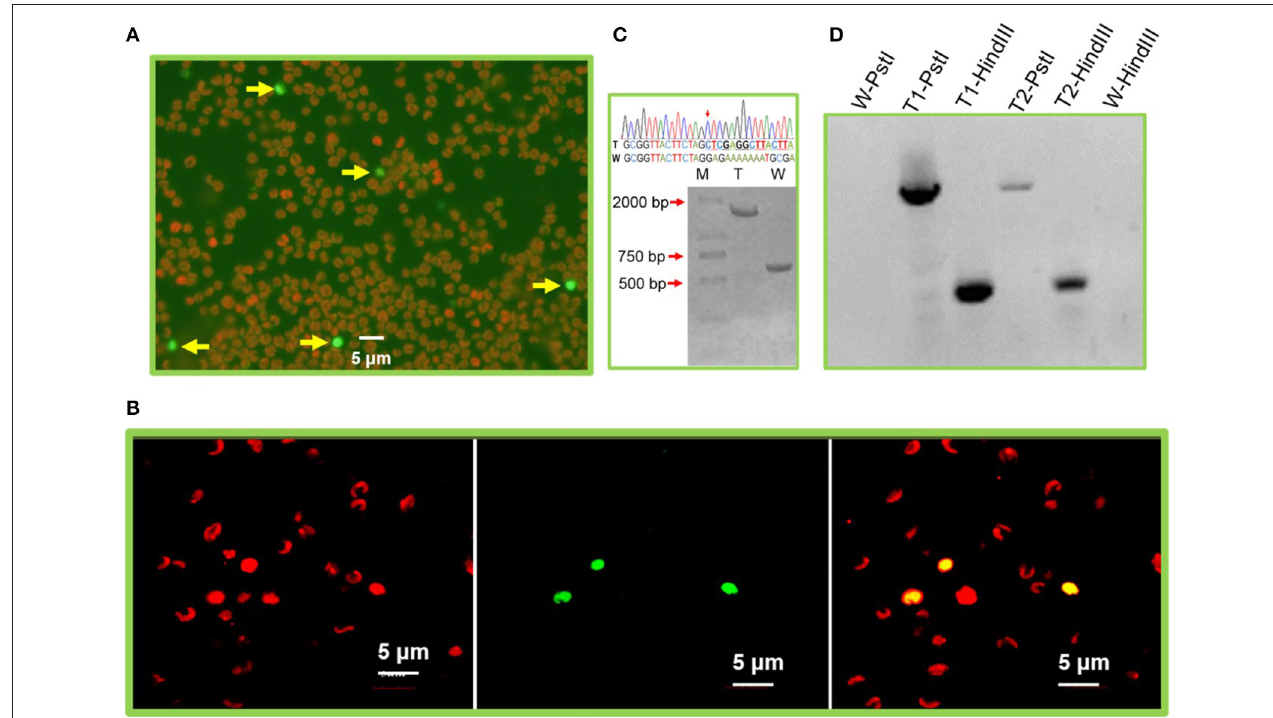
FIGURE 2 | Exogenous gene expression in the N. oceanica chloroplast. (A) Microscopy images of GFP signals from representative microalgal cells transformed by pMEMc1. The fluorescent micrographs show the GFP expressing cells with green color (excitation: 488nm, emission: 500–545nm) and wild type cells with auto red fluorescence of chlorophyll (excitation: 559nm, emission: 570–650nm). (B) Laser confocal microscopic observation of N. oceanica pMEMc1 transformants. Left, chlorophyll fluorescence; middle, GFP fluorescence; right, merged image. (C) PCR amplification of wild-type cells and pMEMc2 transformants genomic DNA using c2-F and c2-R primers. PCR product of wild type cells generates a single 0.6kb DNA band. Homoplasmic cells harbors a 1.3kb transforming constructs ( rbcL - ble - psbA ) and was expected to generate a single 1.9kb DNA band. (D) DNA gel blot of pMEMc2 transformants. Wild-type cells was used as a control. Genomic DNA was digested with restriction enzyme Hind III or Pst I and blotted with DIG-dUTP labeled ble gene probes. W, Wild-type cells; T, pMEMc2 transformants; -PstI, genomic DNA digested Pst I; -HindIII, genomic DNA digested Hind